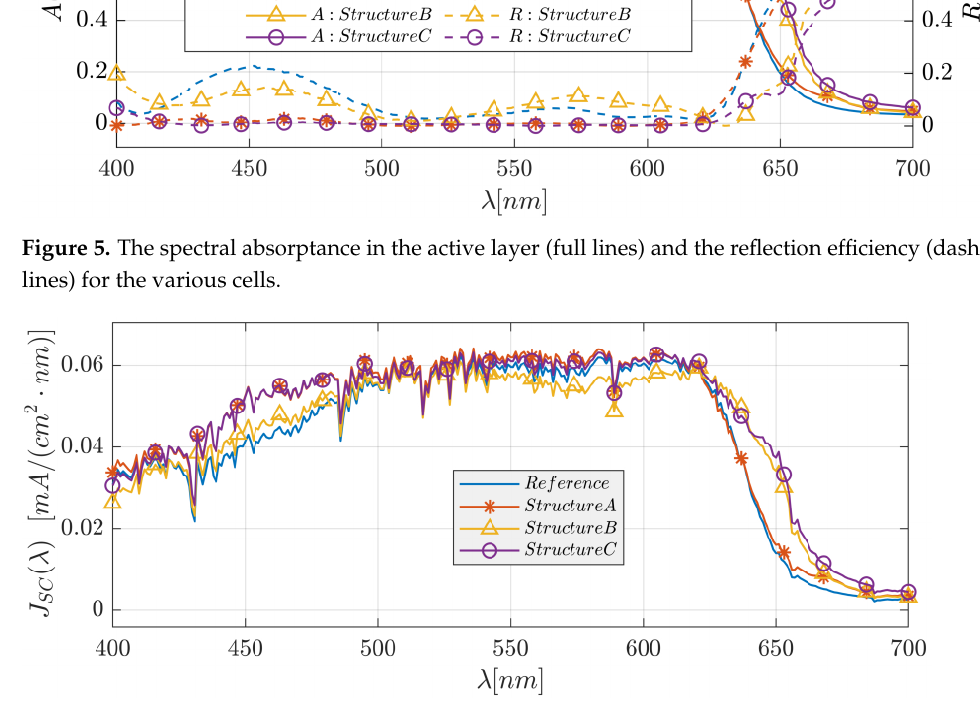
Figure 6. The short-circuit current density spectra of the reference solar cell structure and solar cell structures A, B, and